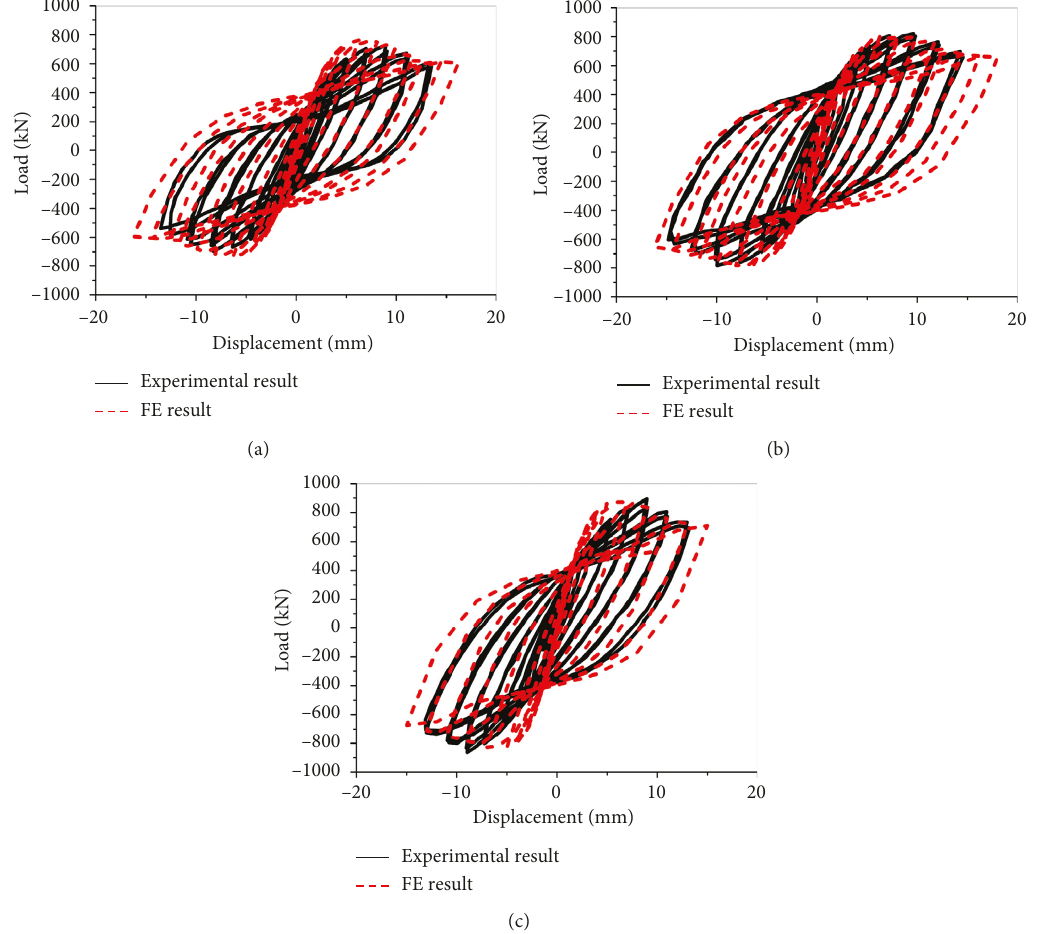
Figure 16: Comparison between experimental results and FE results. (a) DSCW-1. (b) DSCW-2. (c)